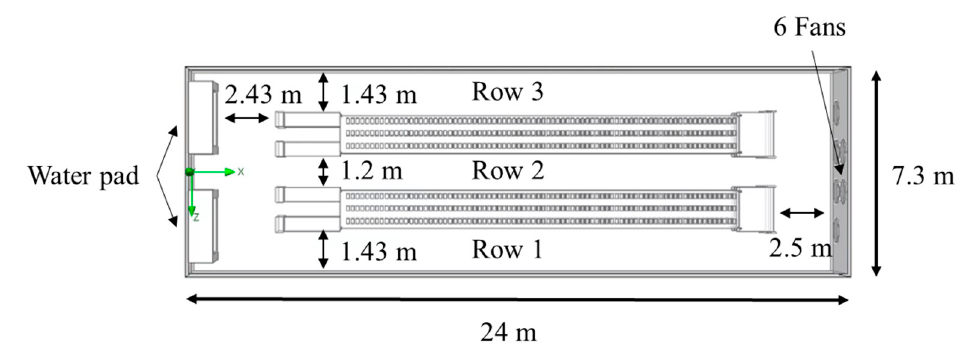
Figure 3. Dimensional drawing of layer house.